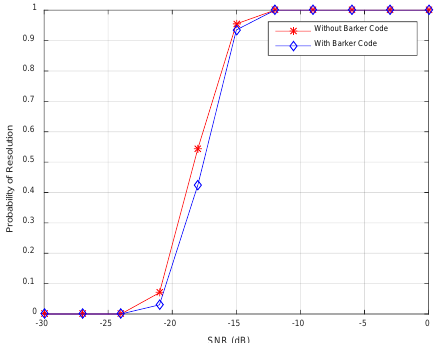
Figure 10. Resolution probability against SNRs.